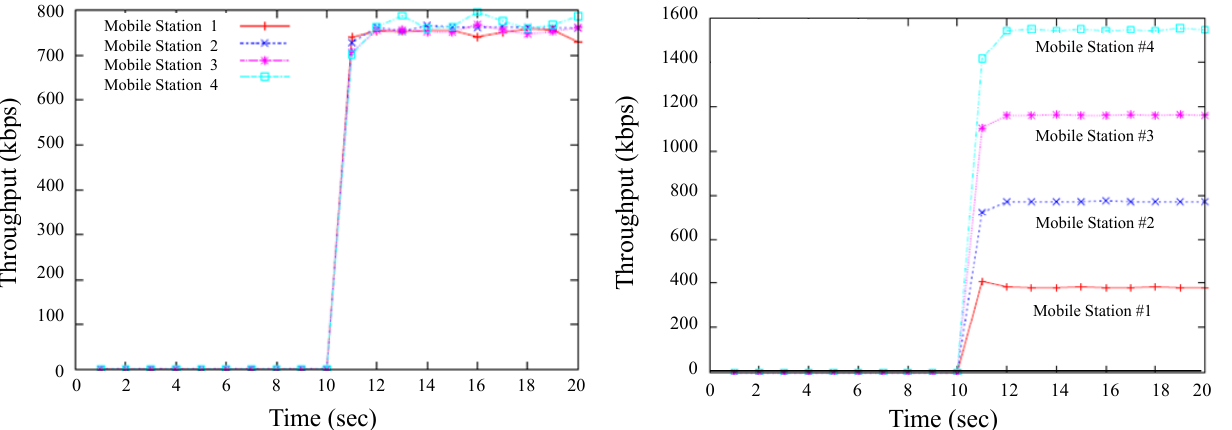
Figure 5. DRRF Throughput. a. (left) 4 flows: with GWF weight 0; b. (right) 4 flows: with GWF weight 1 [11].